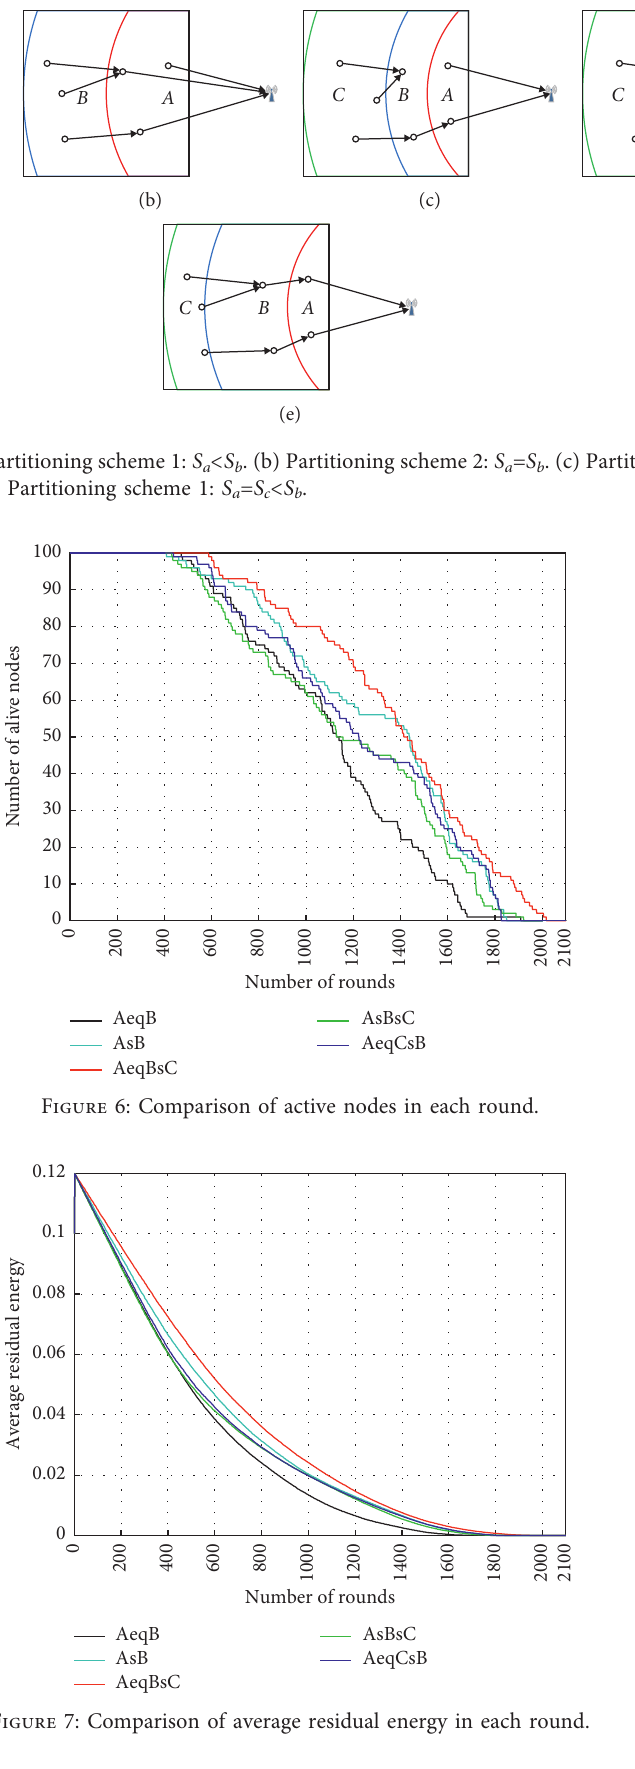
Figure 7: Comparison of average residual energy in each